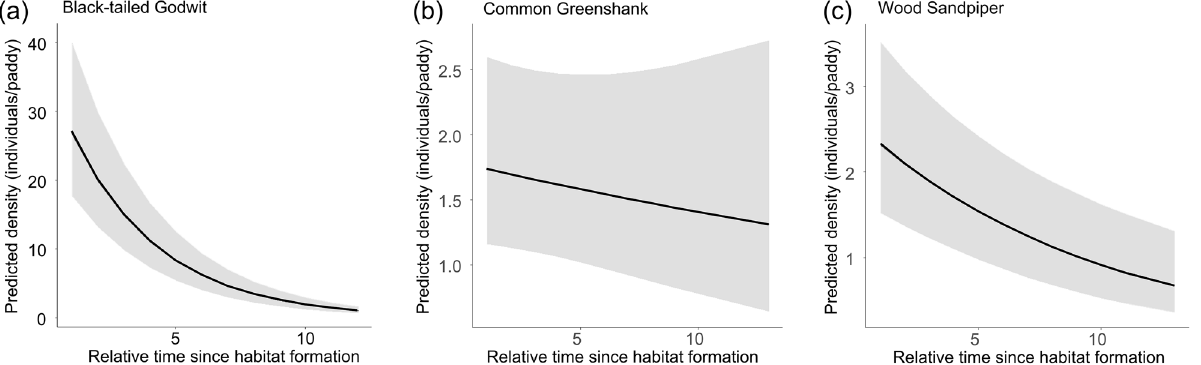
Figure 3. Line graphs showing the predicted density (individuals/paddy) of shorebirds based on relative time since habitat formation. The predicted density was estimated using a generalised linear mixed model with predicted density (individuals/paddy), as the response variable (sample size: black-tailed godwit = 809; common greenshank = 250; wood sandpiper = 465), field type (plowed, harrowed, or seeded) and time since habitat formation as explanatory variables, and survey time and individual paddy as stochastic variables. Lines show the mean predicted density, and the grey-shaded area shows the 95% confidence interval. Each unit on the x-axis represents relative time since habitat formation in 2–3-day intervals: ( a ) Black-tailed Godwit; ( b ) Common Greenshank; ( c ) Wood